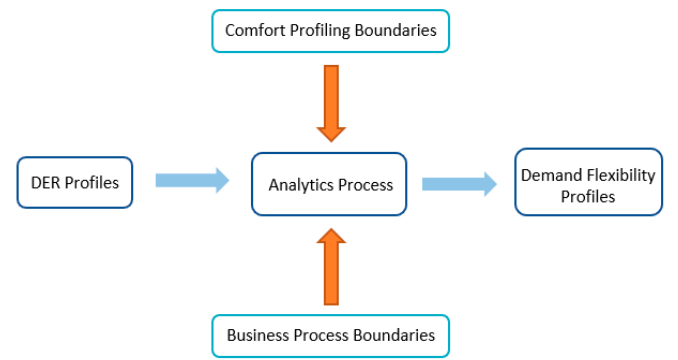
Figure 4. Demand flexibility profile analysis process. DER: distributed energy resource.